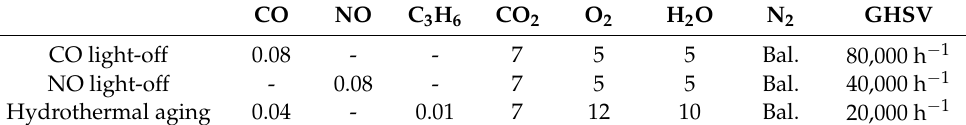
gas mixture did not contain NO. Light off measurements were done after a reductive pre- treatment with 3% H 2 in N 2 at 350 °C for 60 min and cooling down in N 2 . As illustrated in Figure 8, the CO light off experiments were executed by heating up from 80 °C to 180 °C with a slope of 3 K/min, further heating to 400 °C and holding for 30 min in oxidative conditions (same gas mixture as chosen for the CO light-off test). Cooling down in N 2 to 80 °C and performing a second run (heating to 180 °C with 3 K/min) allows a direct com- parison between the catalytic activity after reductive and oxidative pretreatment. Simi- larly, the NO light off was executed by heating up from 160 °C to 320 °C with a slope of 3 K/min, followed by cooling down in N 2 to 80 °C and performance of a second run (heating to 320 °C with 3 K/min). Table 2. Gas concentrations in vol.% used during the light-off measurements and during sample aging. CO NO C 3 H 6 CO 2 O 2 H 2 O